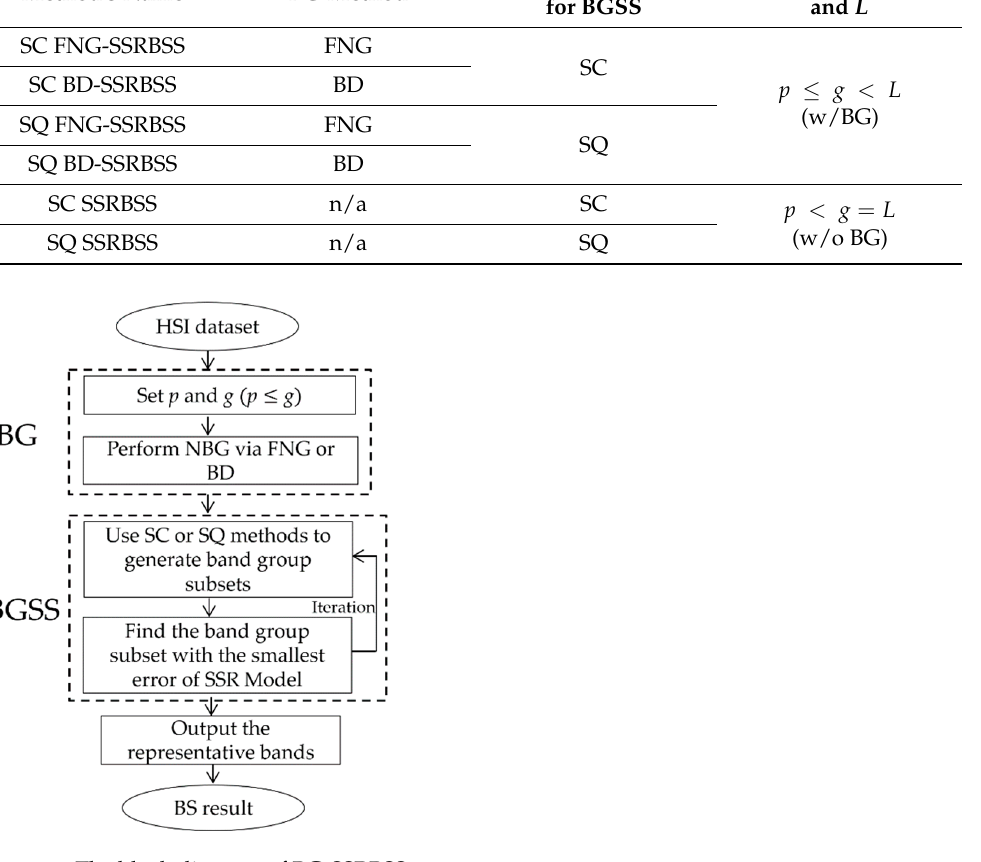
Figure 3. The block diagram of